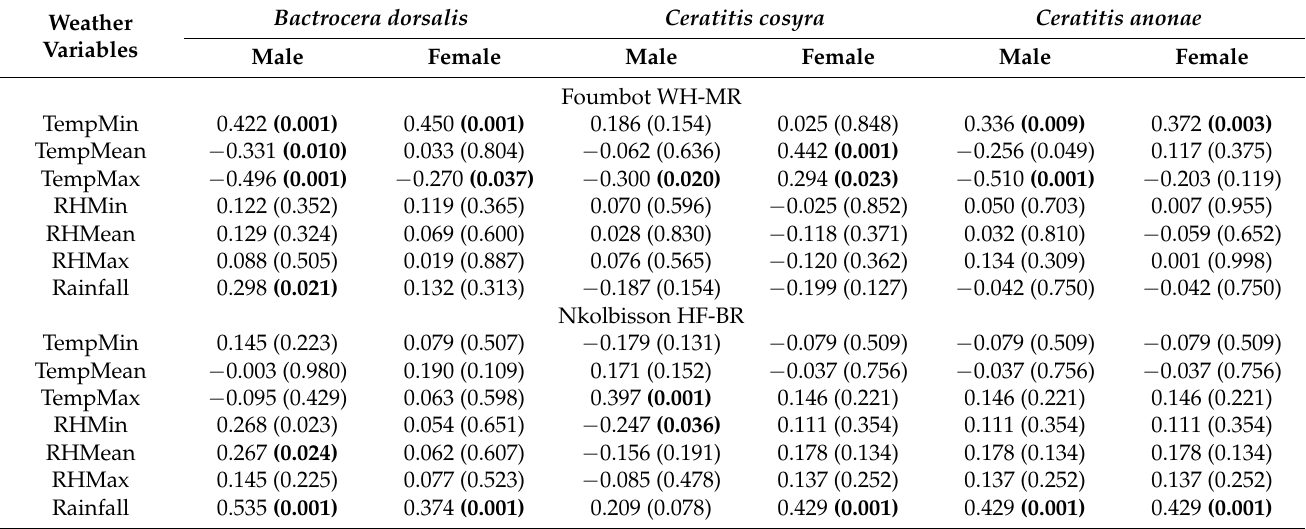
Table 6. Spearman’s correlation coefficient between weather variables and fruit fly species commonly caught per trap per month in the two agro-ecological